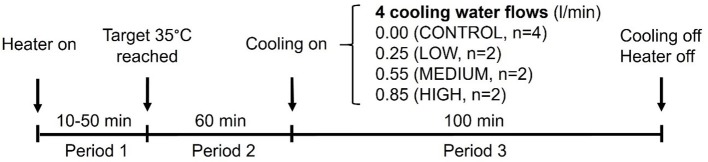
Protocol followed for each repetition of the trial. The protocol for the 10 sows was repeated 8 times (2 times/day for 4 days). The water flow rates assigned for each sow were calibrated before the trial. Behavior and heart rate were recorded continuously over the 3 periods.